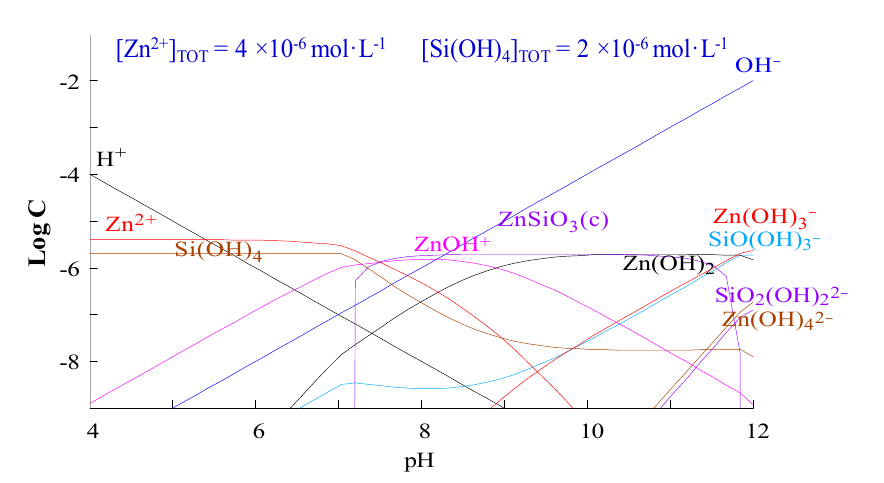
Figure 10. Zn or Si species of hemimorphite in water.